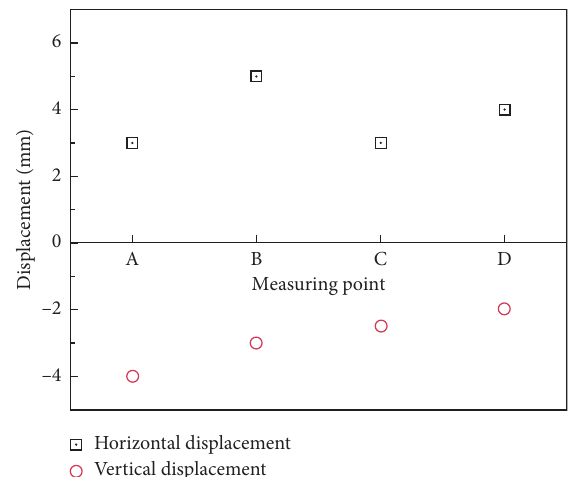
Figure 7: Displacement survey map during normal operation